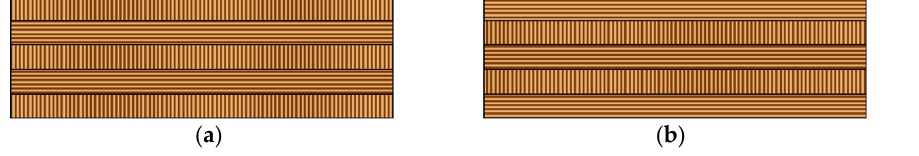
Figure 2. Wood fiber direction. Longer dimension (4155 mm) with 2 resistant layers ( a ). Shorter dimension (3000 m) with 3 resistant layers ( b ).